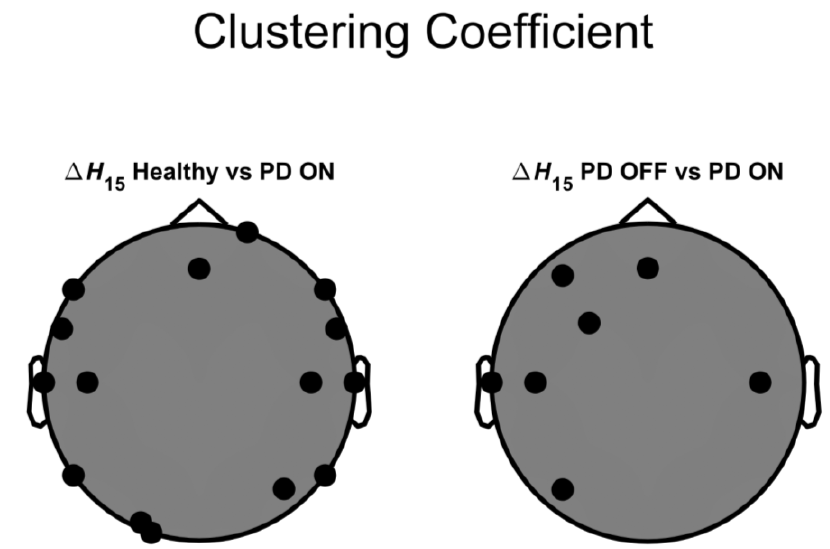
Figure 3. Brain regions with significantly different clustering coefficients in ∆ H 15 networks. The black disks represent the regions whose comparison was statistically significant, i.e., Benjamini–Hochberg adjusted p -value < 0.05. HC: healthy control, PD OFF: Parkinson’s disease patients off medication, PD ON: Parkinson’s disease patients on medication.